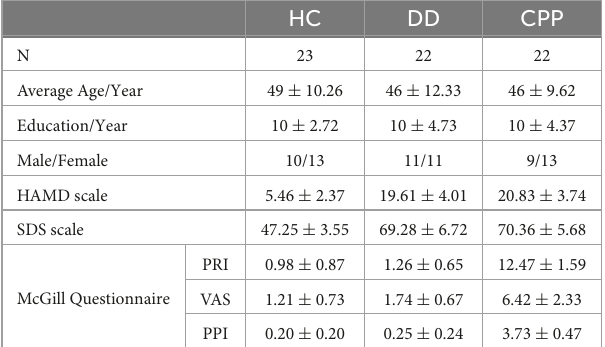
TABLE 1 Number of subjects in three categories (N), average age, years of education, sex ratio, the average score of HAMD, the average score of SDS, and the average score of McGill Questionnaire.